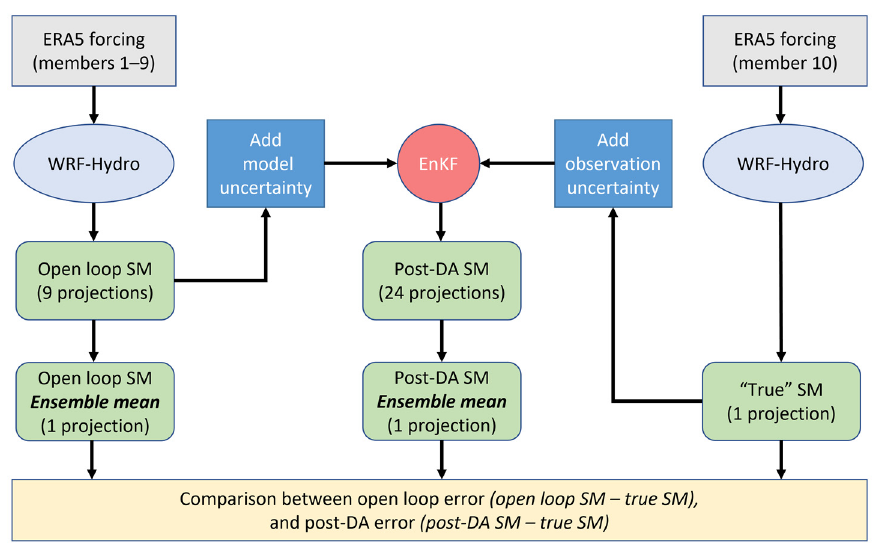
Figure 3. Flowchart describing the design of the synthetic experiments.